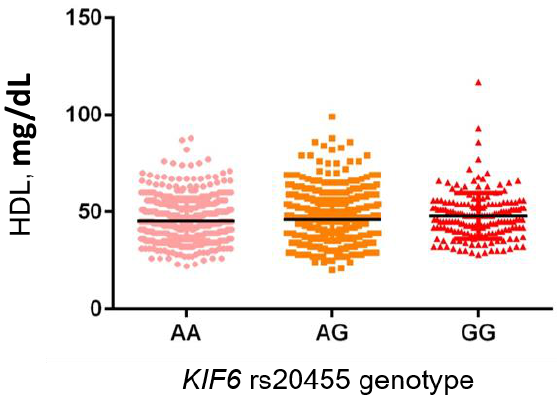
Figure 3. Association of the variant in KIF6 gene (rs20455) with HDL-C level in a subset of the Brisighella heart Study population. Black lines represent HDL-C mean value.